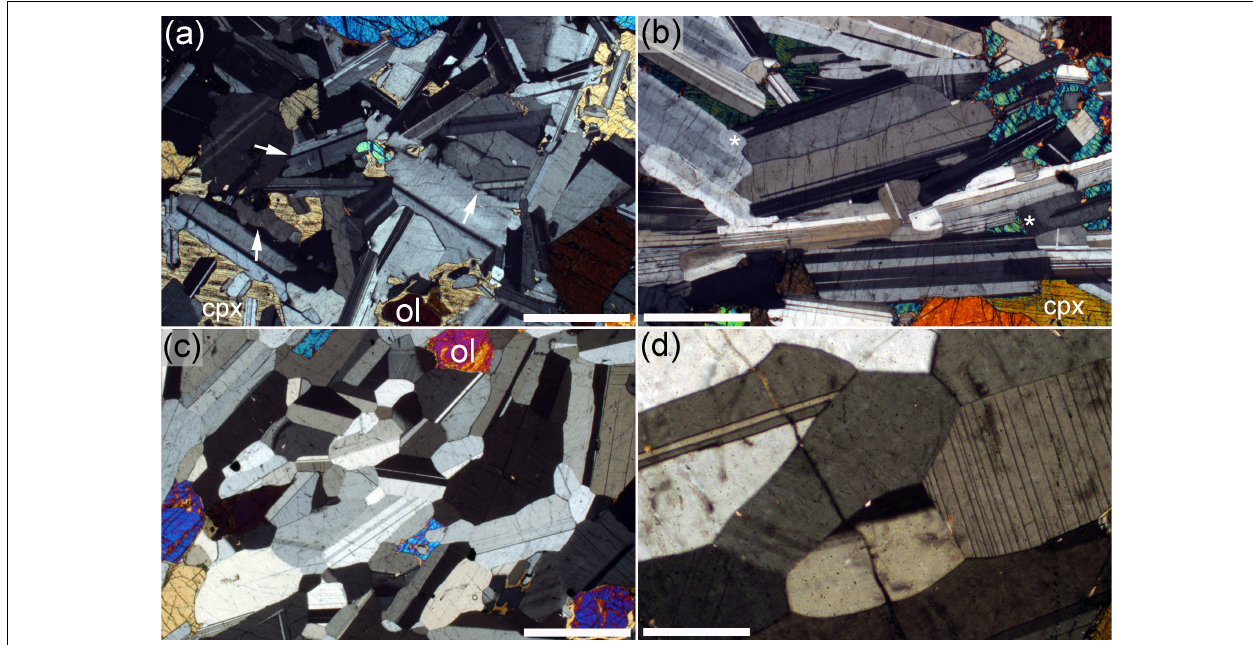
FIGURE 4 | photomicrographs of Skaergaard and Rum troctolites, all photographed under crossed polars. (a) Sample from lower part of HZ, containing primocrysts of olivine and plagioclase with interstitial clinopyroxene. There is no preferred alignment of elongate plagioclase. Note the irregularity of the grain boundaries (examples are arrowed) that are not parallel to expected growth faces in the two grains on either side. Scale bar is 1mm long. (b) LZa sample from the upper part of the 1966 drill core, in which plagioclase primocrysts show a well-developed shape preferred orientation. Grains are commonly bounded by expected growth faces parallel to (010). Compositional zoning is confined to the ends of the elongate laths (examples are shown by asterisks), demonstrating that grain boundaries parallel to the large (010) faces were formed as equant grains were brought together mechanically. Scale bar is 1 mm long. (c) Troctolite from Unit 12 of the Rum Eastern Layered Series. Note the rounded grain boundaries in the plagioclase-rich regions, with significant modification of the original euhedral shape of these primocrysts. Scale bar is 1mm long. (d) Plagioclase-rich region of Rum Unit 12 troctolite demonstrating the almost granular microstructure indicative of extensive sub-solidus textural equilibration. Scale bar is 200 µ m